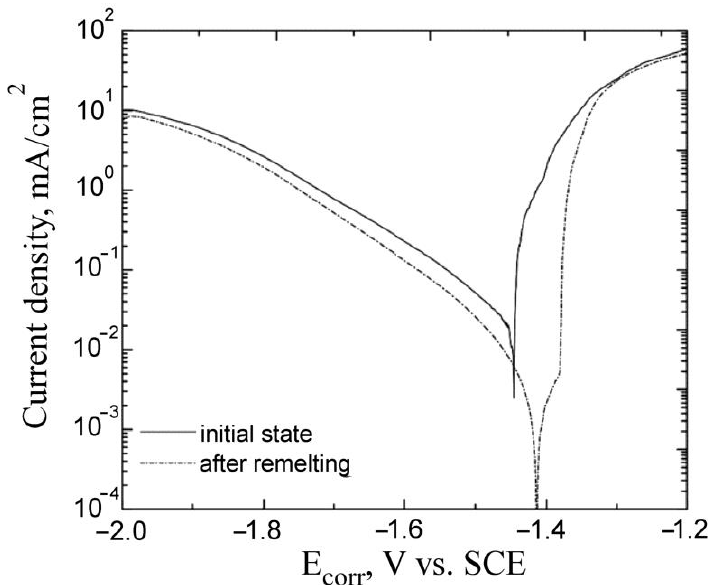
Figure 5. Polarization curves of remelted and non-remelted AZ91 alloy. For the remelted samples the E corr value was − 1.41 V in relation to SCE, while for the non-remelted ones it was − 1.44 V in relation to